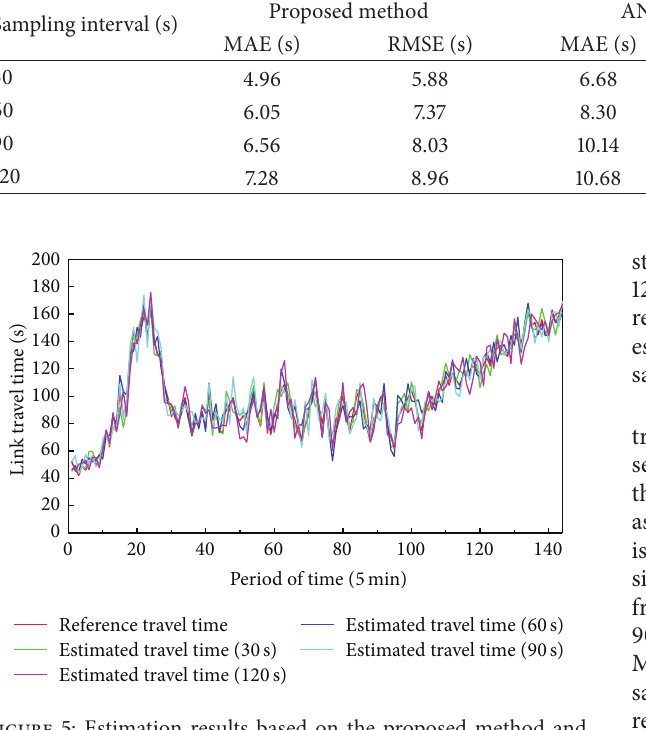
Figure 5: Estimation results based on the proposed method and different sampling